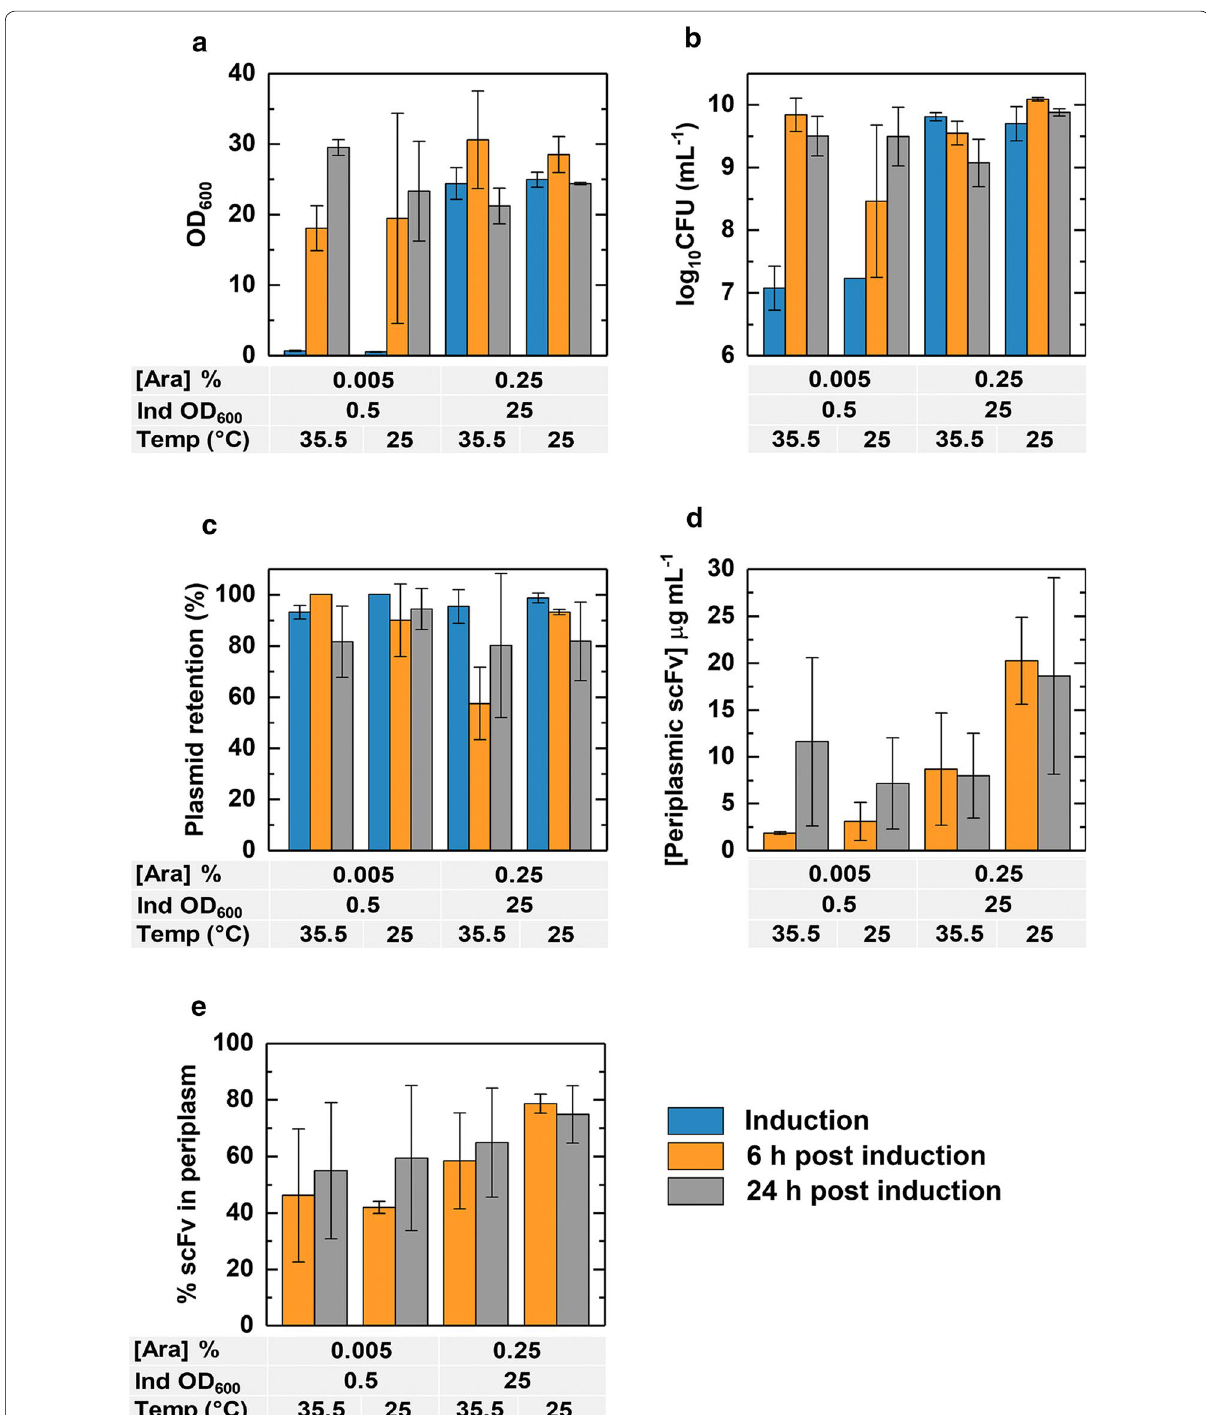
Fig. 7 Baffled shake flask experiments to determine the effect of different growth temperatures and inducer concentrations. Cultures were grown in 100 mL of terrific broth in 500 mL baffled shake flasks and samples were taken at induction and at 6 h and 24 h after induction. Samples were analysed for OD 600 ( a ), CFU mL − 1 ( b ), percentage plasmid retention ( c ), periplasmic scFv concentration ( d ) and percentage of scFv in the periplasm ( e